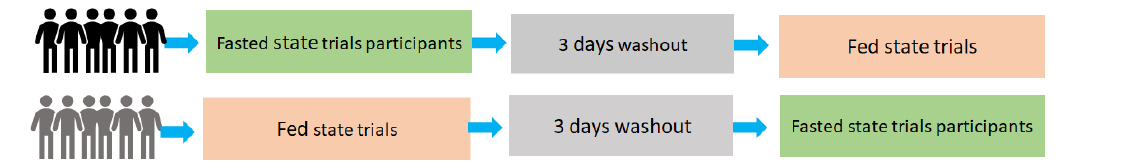
Figure 1. A counterbalanced design was applied, and, therefore, all participants completed both the fed and fasted